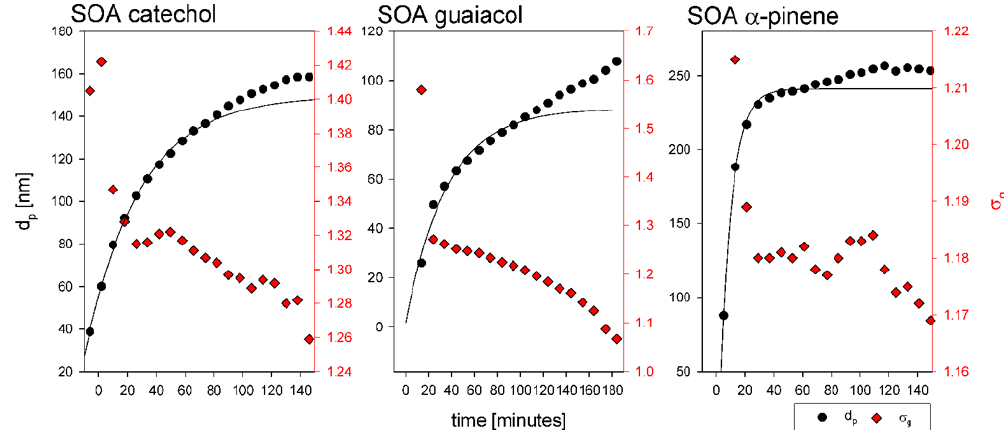
Fig. 9. Evolution of the mean particle diameter ( d p ) and the related geometric standard deviation ( σ g ) of SOA from the different model aerosols while interacting with RHS released from the simulated salt pan.